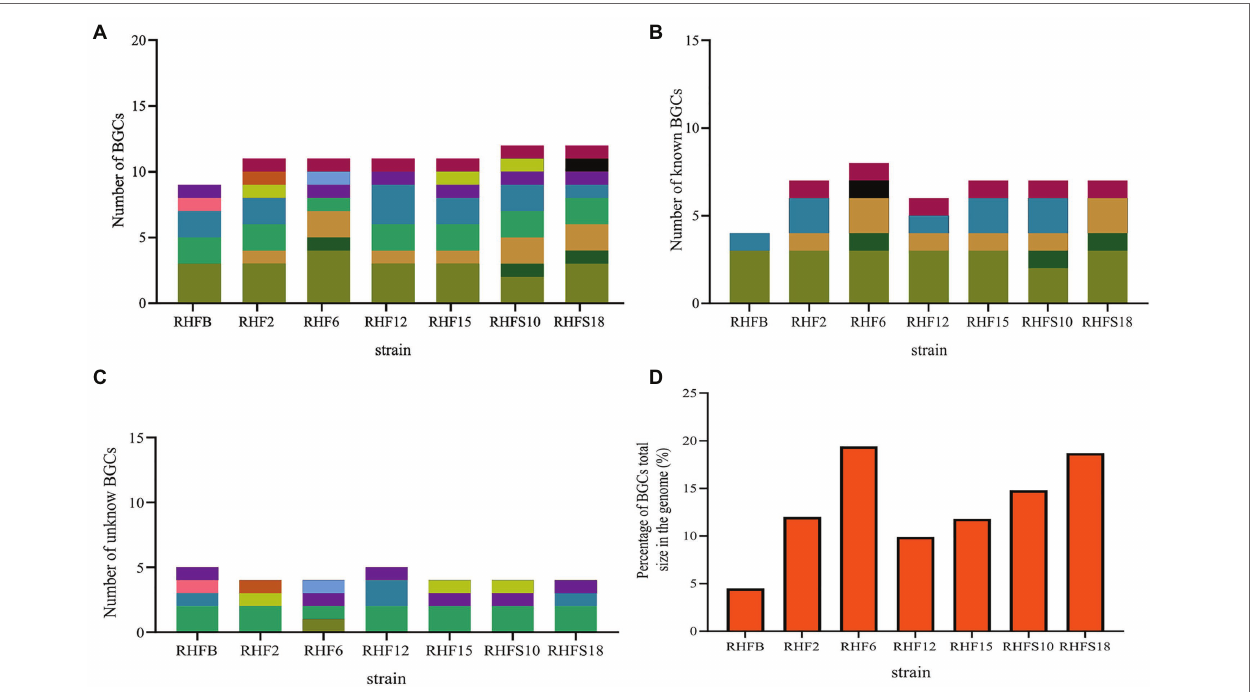
FIGURE 5 | Number of biosynthetic gene clusters harbored by the strains and the percentage contribution of Biosynthetic Gene Clusters (BGCs) to the total genome size. (A) Total number of BGCs; (B) number of reported BGCs in the genomes; (C) number of unknown BGCs. BGCs that have different numbers of genes or show less than 70% protein identity to the reported ones were regarded as novel; and (D) the percentage contribution of BGCs to the genomes.